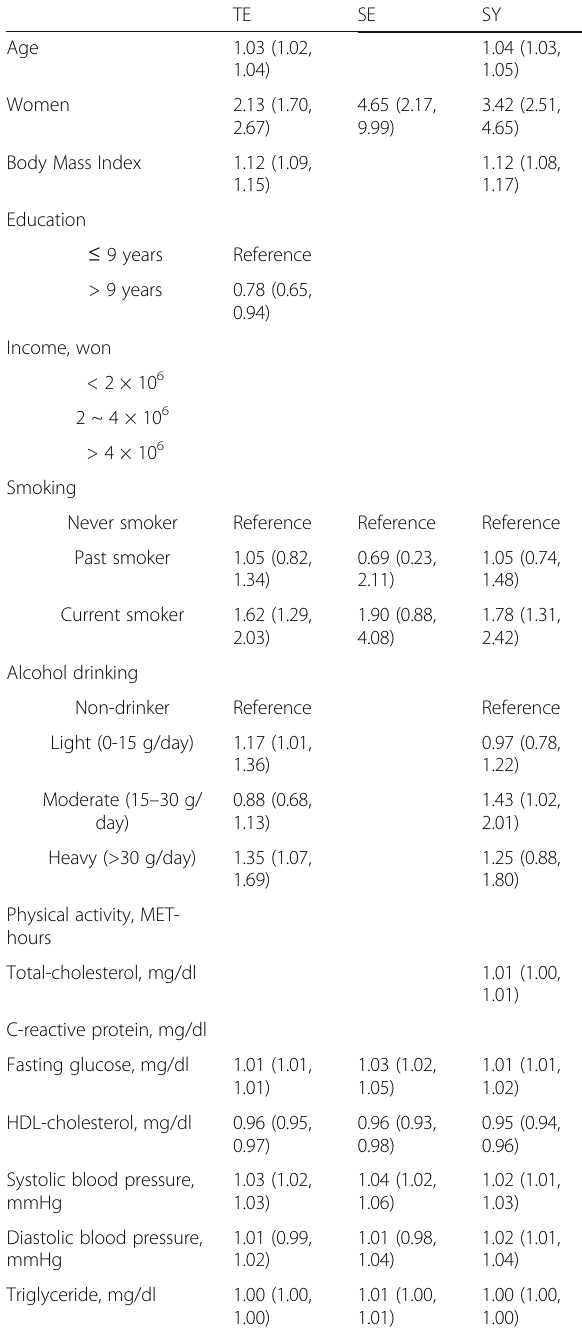
Table 3 Selected Predictors according to Sasang